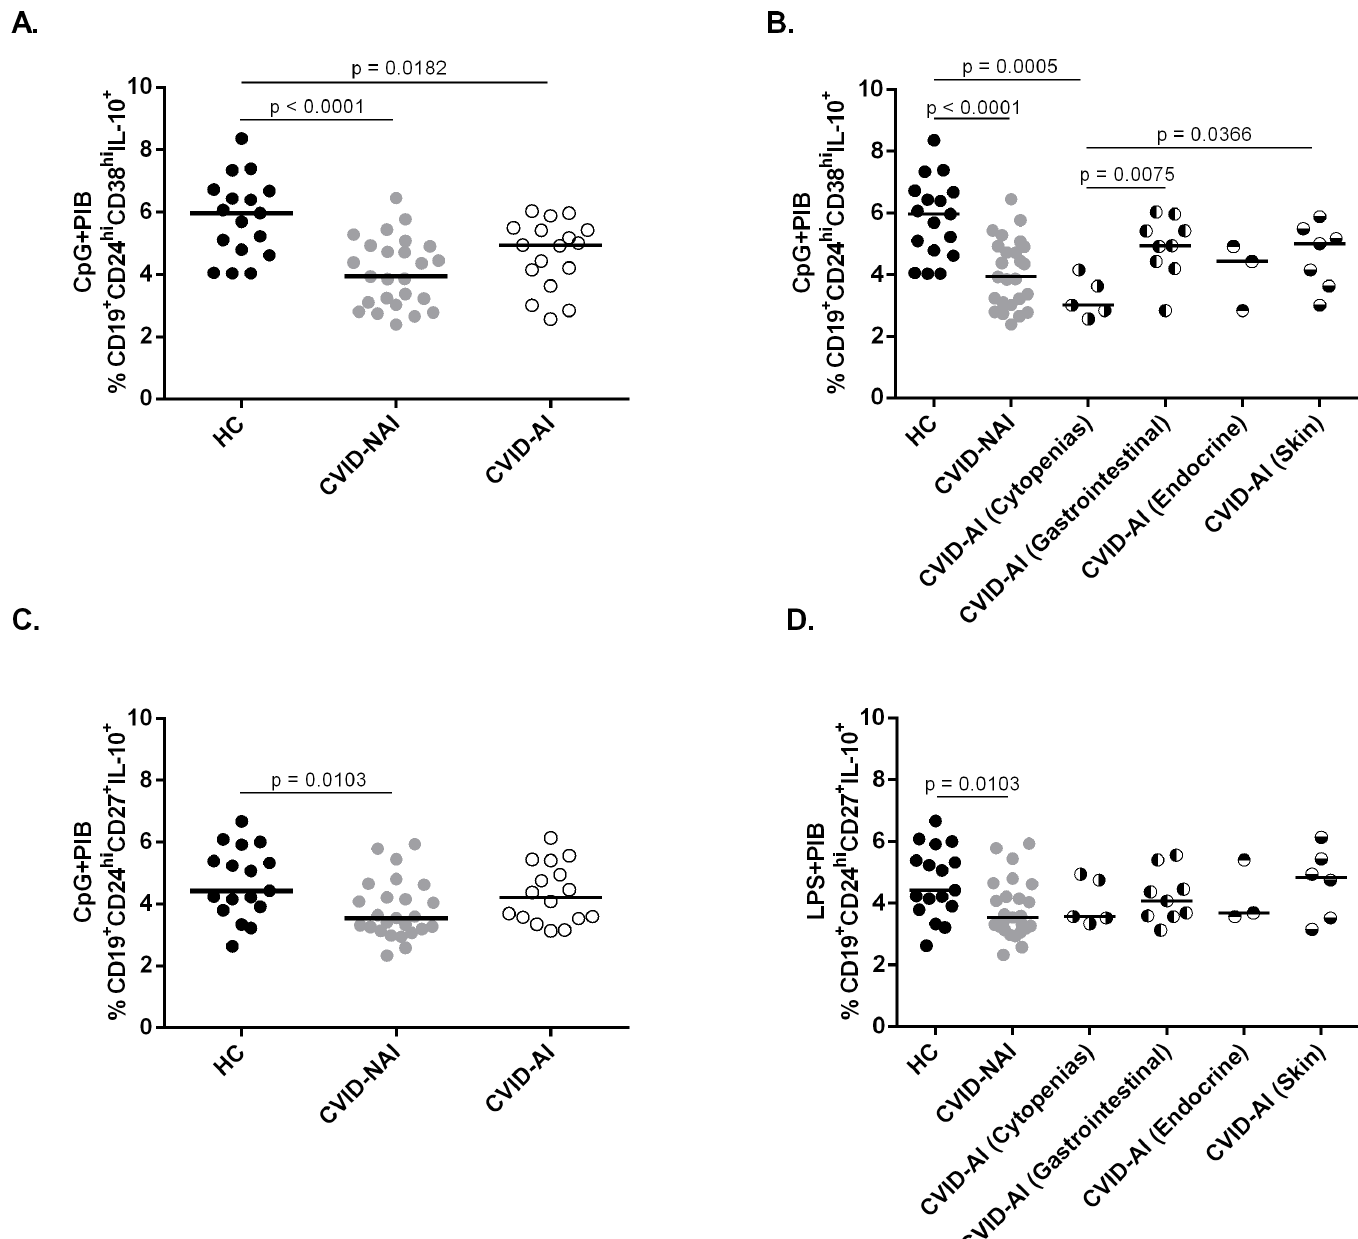
Fig 4. Frequency of IL-10-producing CD24 hi CD38 hi and CD24 hi CD27 + B cells in CVID-NAI and CVID-AI patients. The expression of intracellular IL-10 and surface markers CD24, CD38 and CD27 were determined by flow cytometry after in vitro stimulation of PBMC for 5h with CpG + PIB. Scatter plots show the percentages of (A,B) CD19 + CD24 hi CD38 hi IL-10 + and (C,D) CD19 + CD24 hi CD27 + IL-10 + B10 cells in peripheral blood of 17 Healthy Controls (HC), 25 CVID-NAI and 17 CVID-AI patients. Bars represent the mean value. P values were calculated by Mann-Whitney test.